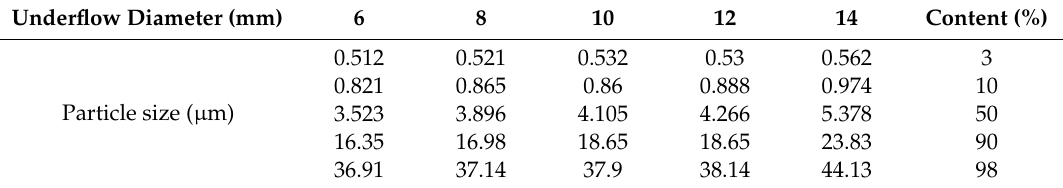
Table 3. Particle size of I inner overflow.